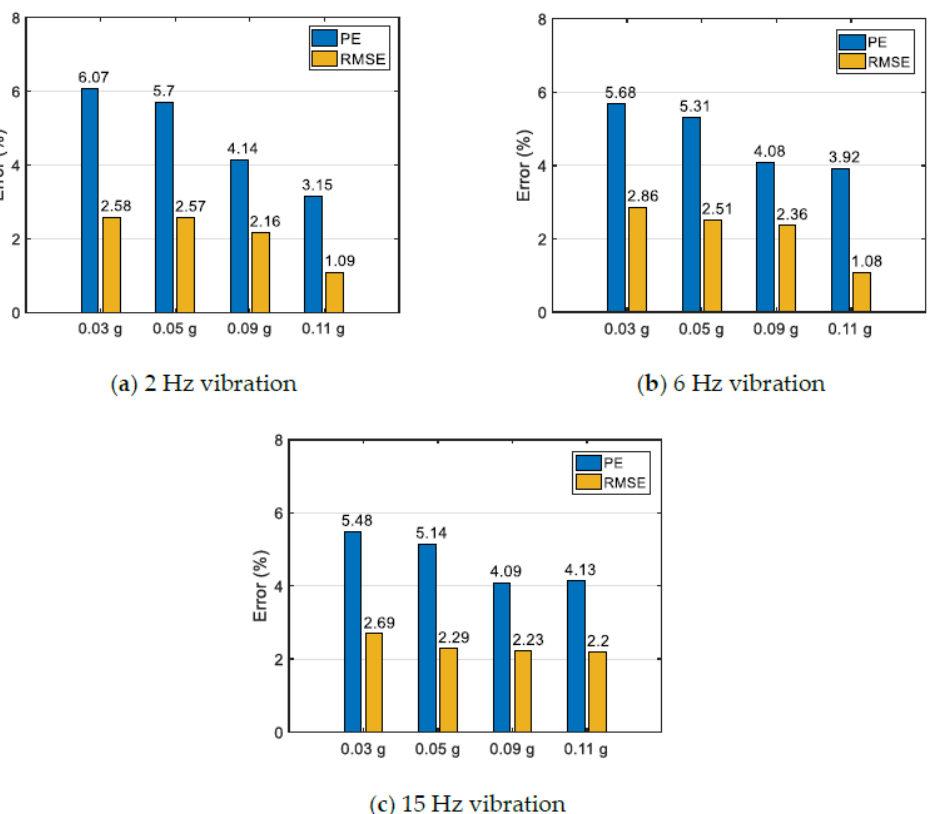
Figure 12. Peak error and root mean square (RMS) error of measured acceleration